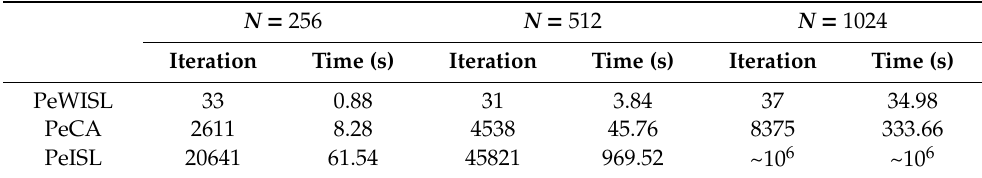
Table 2. The convergence performance of three methods.